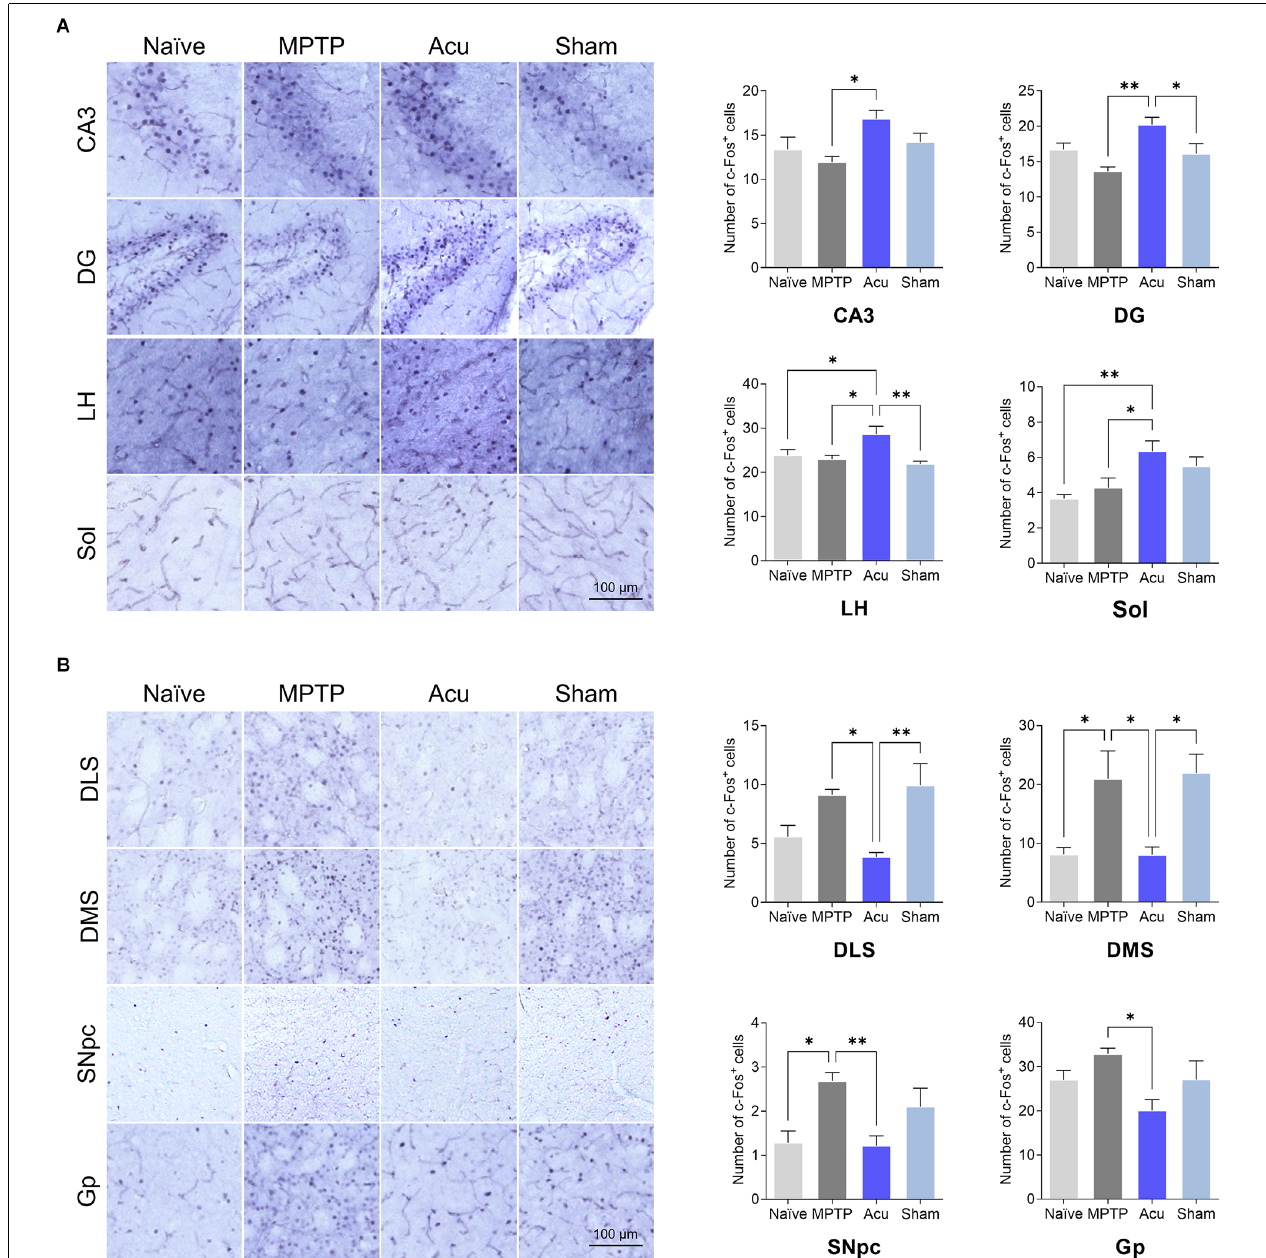
FIGURE 6 | Expression of c-Fos after acupuncture treatment expressed in each brain region. (A) Brain regions with increased c-Fos activity after acupuncture. (B) Brain regions with decreased c-Fos activity after acupuncture treatment. n = 6/group, ∗∗ p < 0.01, ∗ p < 0.05. All data are mean ± SEM following the one-way ANOVA followed by the Tukey’s test. CA3, Field CA3 of hippocampus; DG, Dentate gyrus; LH, Lateral hypothalamus; Sol, Nucleus of the solitary tract; DLS, Dorsolateral striatum; DMS, Dorsomedial striatum; SNpc, Substantia nigra parscompacta; Gp, Globus